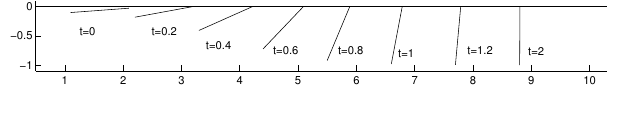
Figure 4. Pole vaulting model. Position of fiber wrt. wall in different time moments.